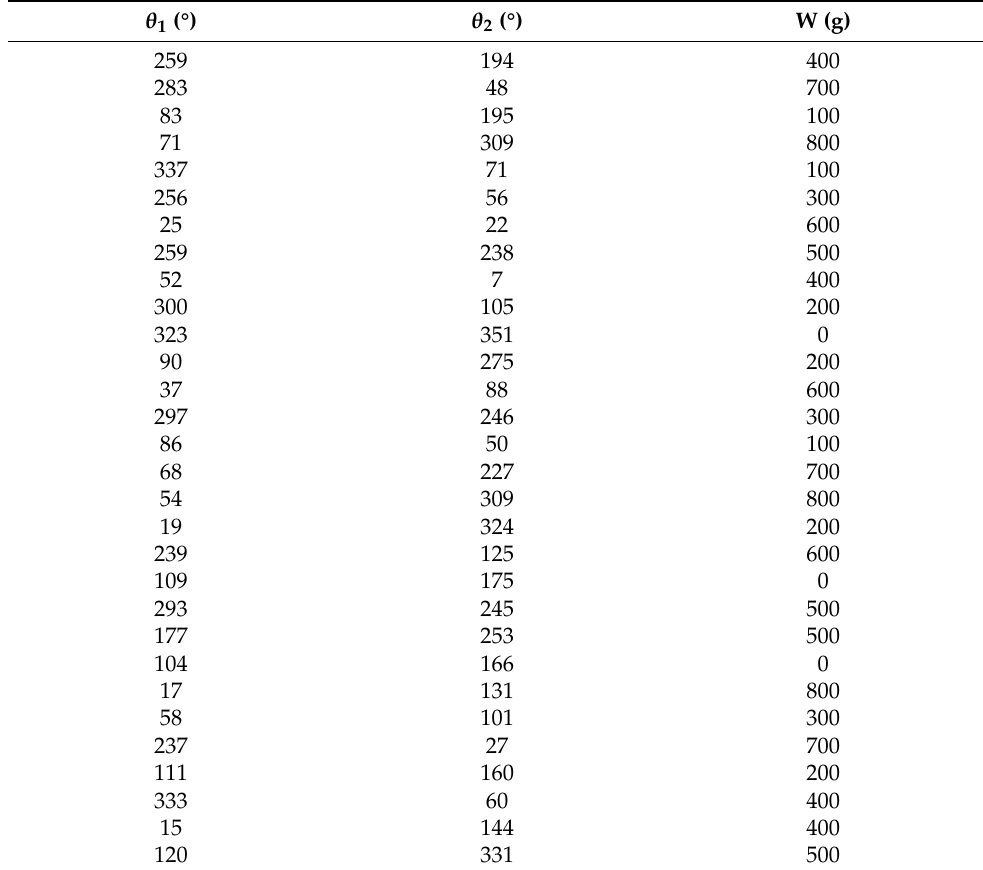
Table 5. Example loading cycle routines for a validation protocol. Each cycle has two rotary stage angles and a loading weight. Stated weights do not include 230g loading